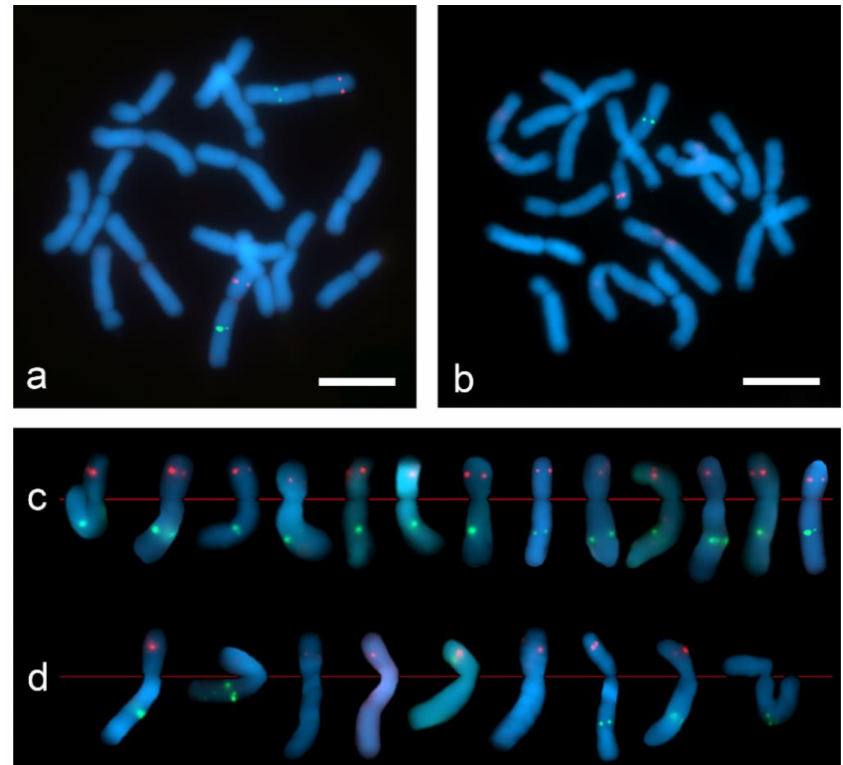
Figure 7. Dual-color Tyr-FISH on mitotic metaphase chromosomes of Allium cepa probing with Unigene572 (red) and Unigene5305 (green): ( a ) “SteamDrop” chromosome preparation; ( b ) squashed chromosome preparation; ( c ) extracted chromosome 2 from metaphases of “SteamDrop” chromosome preparations; ( d ) extracted chromosome 2 from metaphases of squashed chromosome preparation. Scale bar—10 µ